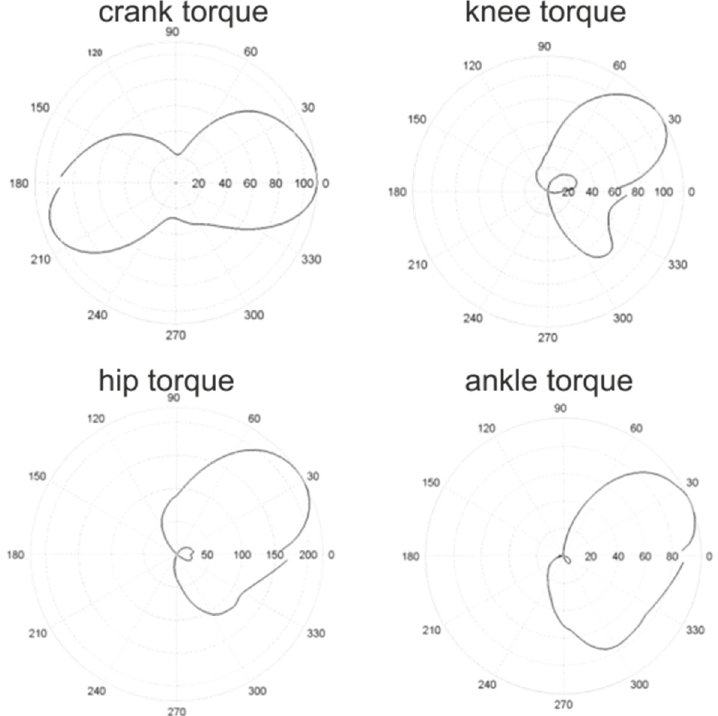
Figure 2. Torque profiles. Polar representation of the torque (N · m) exerted at the crank axis and at the knee, hip and ankle joints computed using the inverse dynamics procedure. Figures have been adapted from Watier et al. (2013) [33]. For this experience, nine triathletes developed a maximal power of 594 ± 100 W at a cadence of 108 ± 9 RPM and a mean crank torque of 53.1 ± 10 N · m. For each joint, the maximum torque was developed during the downstroke. During the upstroke, there was a sign inversion of the torque at each joint of the lower limbs, meaning that subjects pulled on the clipless pedals. When normalized to body mass, the maximum extension torque at the ankle was 1.14 ± 0.27 N · m / kg in extension and 0.18 ± 0.09 N · m / kg in flexion. At the knee, the maximum torque was 2.89 ± 0.70 N · m / kg in extension and 0.67 ± 0.28 N · m / kg in flexion. At the hip, it reached 1.48 ± 0.45 N · m / kg in extension and 0.50 ± 0.14 N · m / kg in flexion. The angular position represents the right crank position which rotates clockwise. The label 90 ◦ corresponds to the pedal in the upper position, and the label 270 ◦ to the pedal in the lower position.